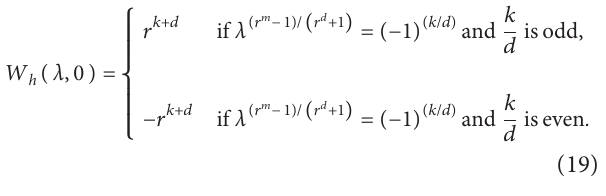
Table 7: Weight distribution of C Weight